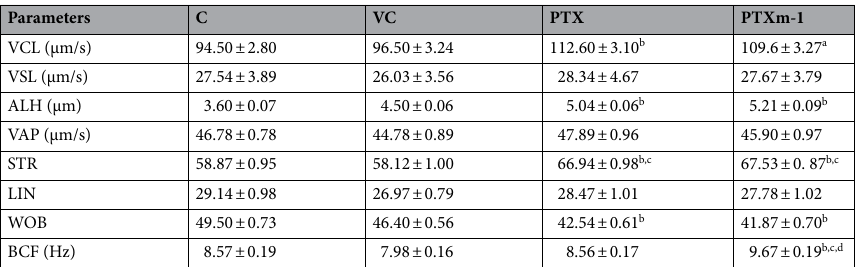
Parameters C VC PTX